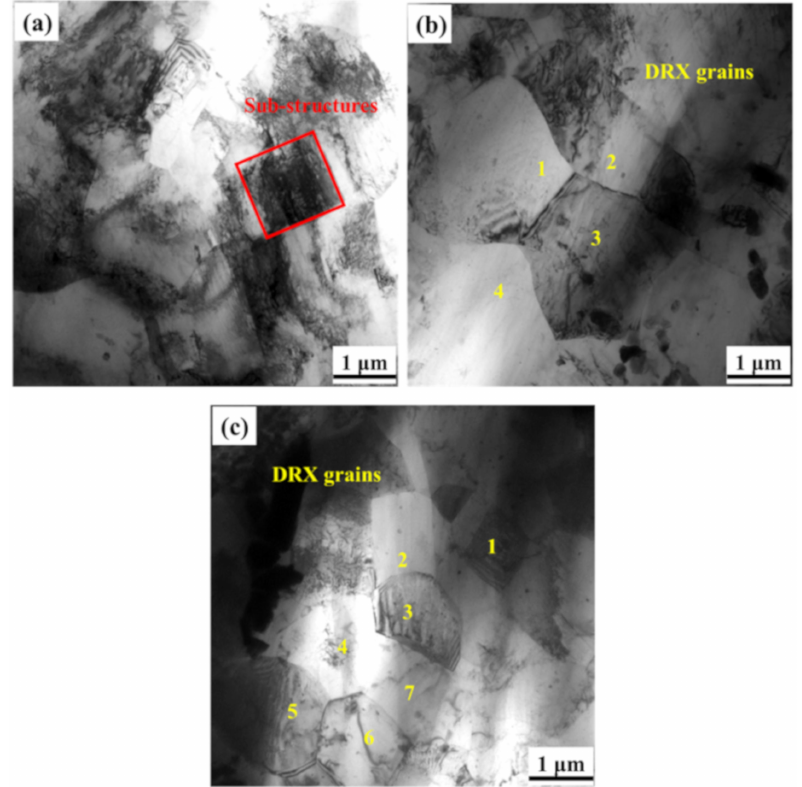
Figure 7. Ddynamic recrystallized (DRX) grains and sub-structured in ( a ) 623 K-4P, ( b ) 623 K-12P, ( c ) 573 K-12P